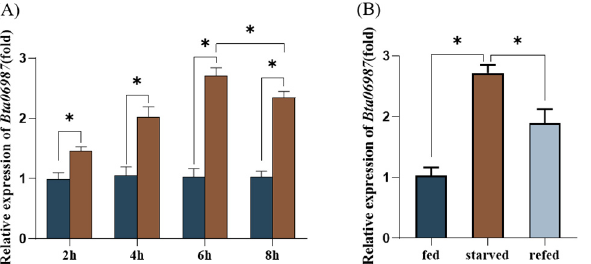
Figure 2. Bta06987 relative expression after starvation. ( A ) Whiteflies were placed in 1.5 mL centrifugal tubes for starvation with 2, 4, 6, and 8 h. ( B ) Food rescue experiment. Data were shown as the mean ± SEM and evaluated by t -test. Bars labeled with the ‘*’ denote significant differences at p < 0.05.